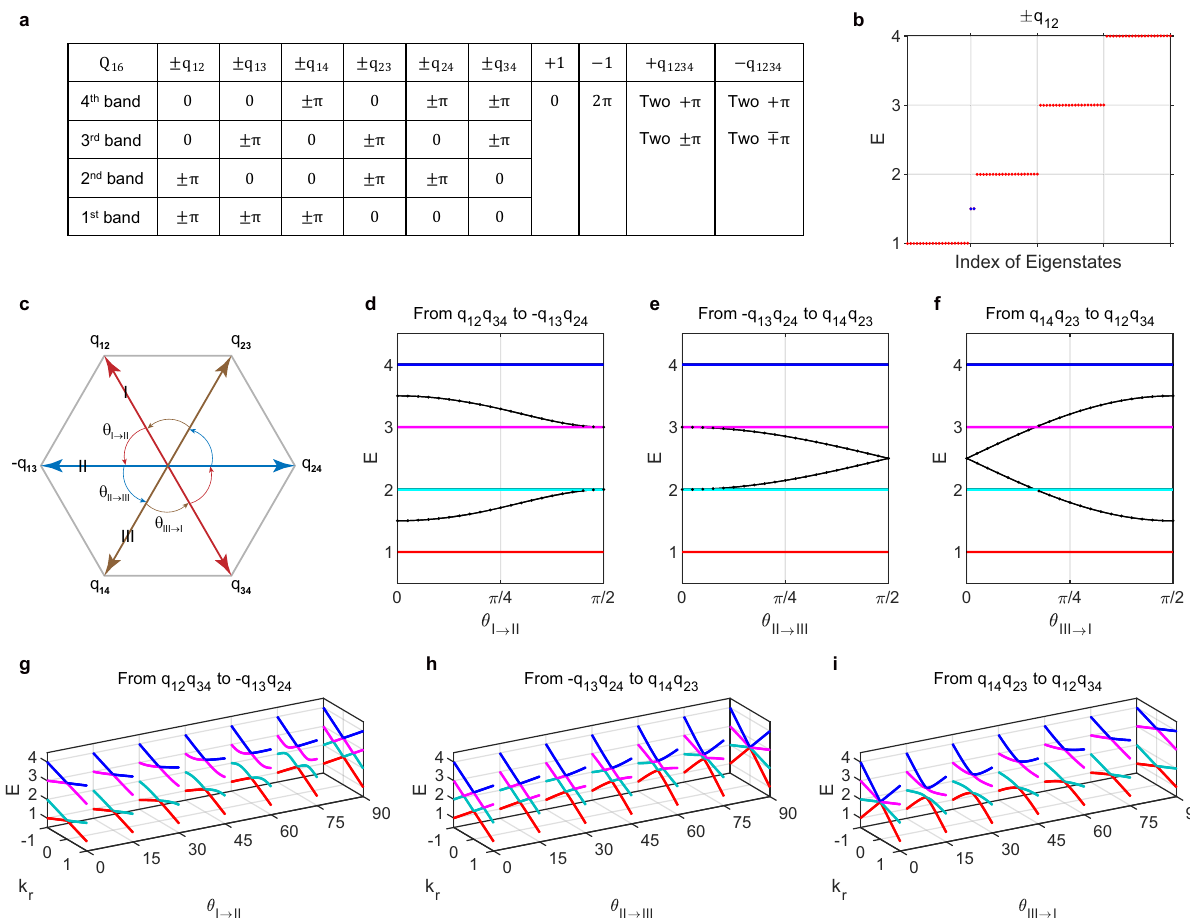
Fig. 3 Zak phases and evolution of edge states. a Zak phases for individual bands summarized for each non-Abelian topological charge. For charges ± q 1234 , two eigenvectors rotate by π , while the other two rotate by þ π or (cid:2) π depending on the factorizations (due to the handedness of the subspace). b Edge states of charges ± q 12 occur at the bandgap sandwiched by the fi rst and second bands. c Schematic view of charge q 1234 factorizations and their mutual continuous transitions. The double-headed arrows indicate that the paired two factors commute, i.e., q 12 q 34 ¼ q 34 q 12 ¼ q 1234 . The directional arcs de fi ne the continuous transitions parametrized by θ m ! n , with m and n taking values of I, II, and III, corresponding to the factorizations of q 12 q 34 , (cid:2) q 13 q 24 , and q 14 q 23 , respectively. d – f Evolution of edge states with varying parameter θ m ! n , where lines/dots indicate the numerical/analytical results. g – i Evolution (cid:4) (cid:5) of the extended 2D bands corresponding to ( d – f ), respectively. Note that we only plot the radial cuts E k r , as the 2D bands for ideal fl at-band models are isotropic in the ( k 1 ; k 2 )